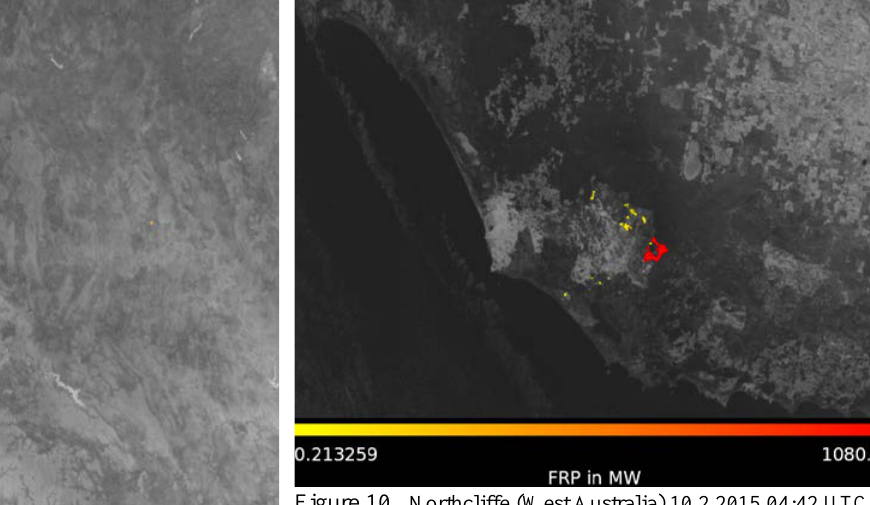
Figure 10 Northcliffe (West Australia) 10.2.2015 04:42 UTC